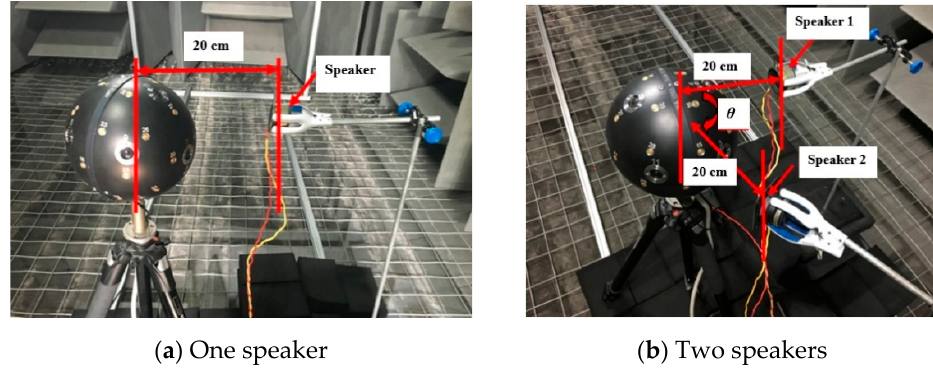
Figure 9. Photographs of the experimental setup.